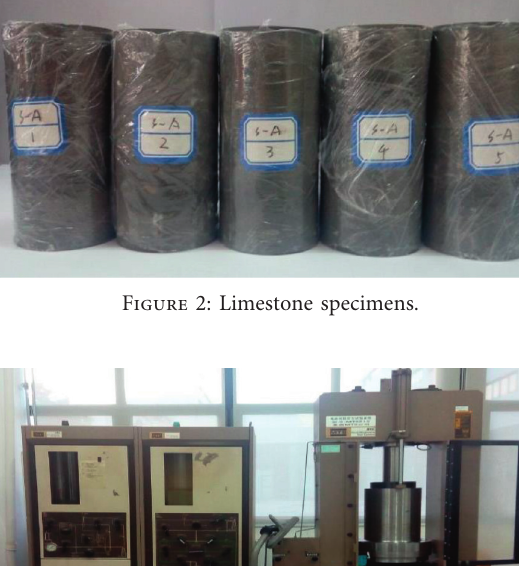
Figure 4: Stress-strain curves of limestone specimens in the conventional compression test. (a) The uniaxial stress state. (b) The confining pressure of